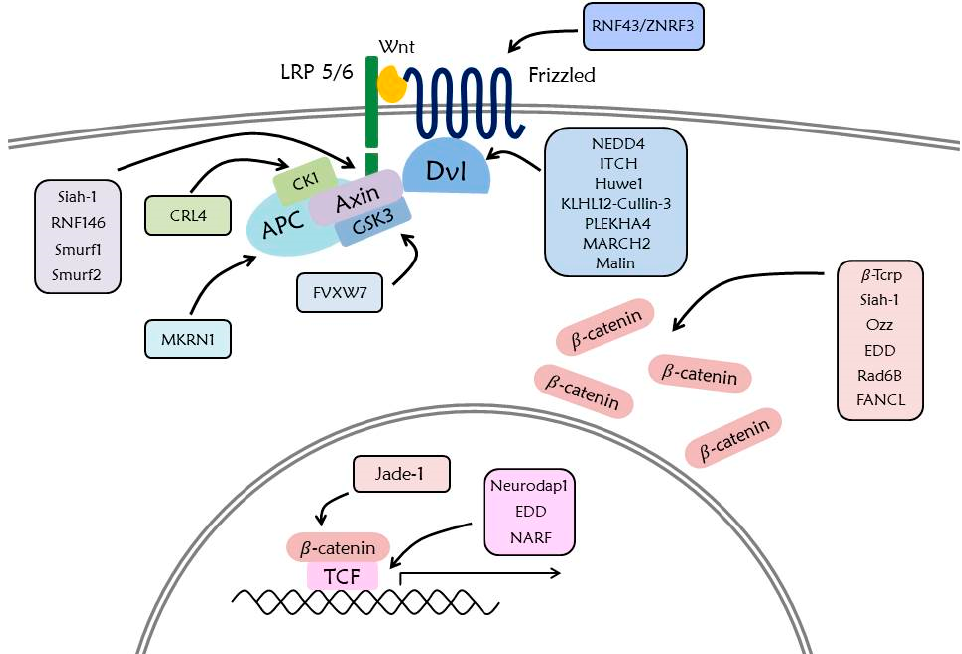
Figure 4. Ubiquitination in the Wnt signaling pathway. Numerous E3 ligases regulate the stability or activity of Wnt signaling factors inducing ubiquitination. Most proteins in the Wnt signaling pathway are regulated by ubiquitination, and many E3 ligases that regulate β -catenin, Dvl, and Axin are well known. The ubiquitination of Wnt signaling pathway has an important role in protein folding and stability through proteasomal degradation.